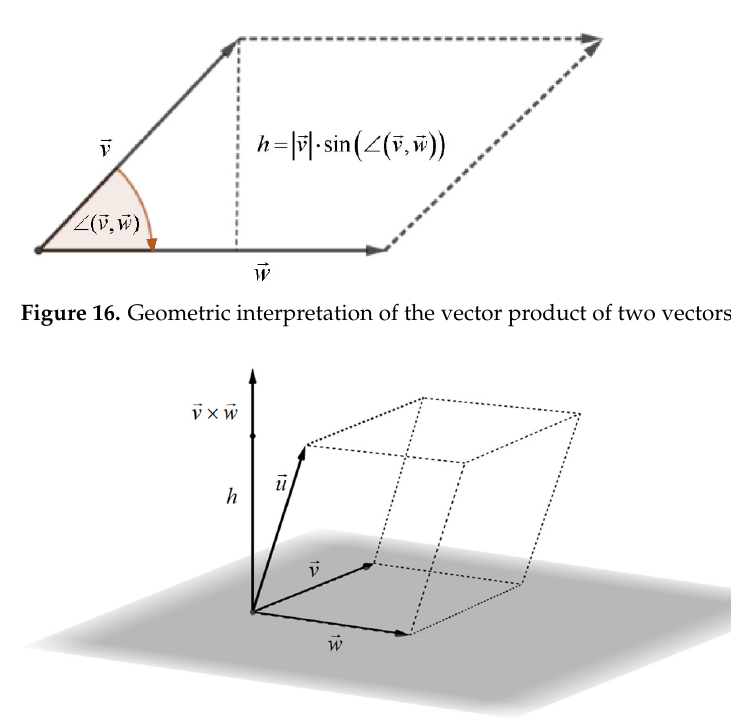
Figure 15. Geometric interpretation of the scalar product of two vectors.